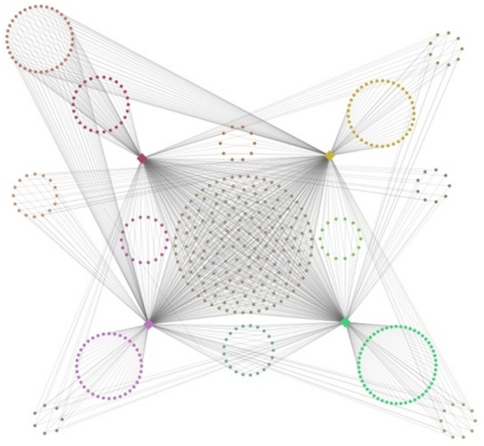
Network representation of ASD predictive gene map matching the dual profile of AutRef84.After initially identifying 1185 genes matching the AutRef84 functional profile, we filtered this set by performing tissue-specific enrichment analysis and network representation of its shared brain regions within the AutRef84 expression profile. Using this method of dual profiling, we defined a prioritized subset of 460 genes predicted to be mutated in individuals with ASD. Within this subset, 159 genes are expressed in all four enriched brain regions of AutRef84, 62 genes were common to three of the enriched brain regions, 89 genes overlapped in two of the enriched regions, and 150 genes were expressed in only one enriched brain region (Table S9). Node placement and coloring were determined as described in
Figure 4
.